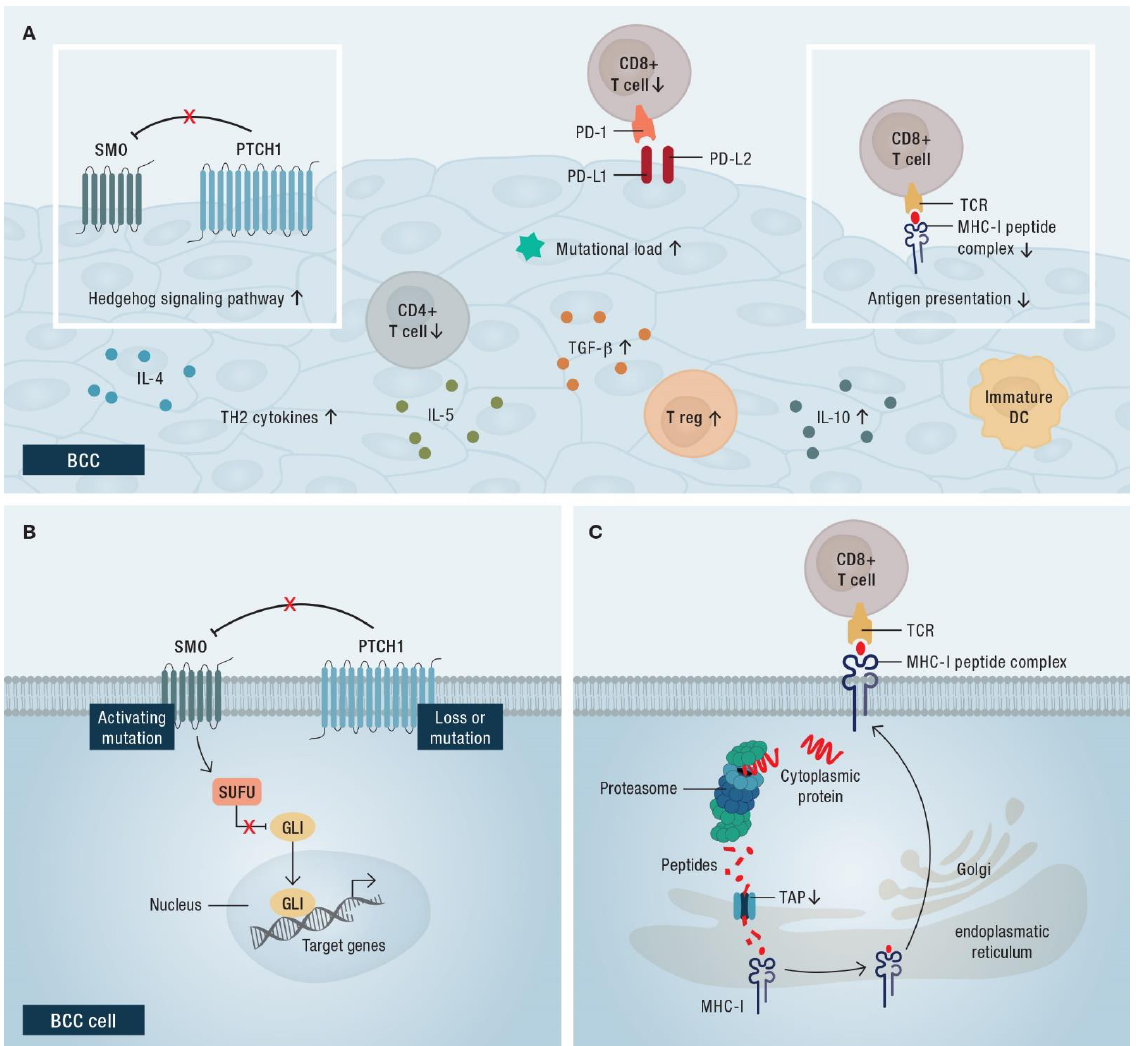
Figure 3. Schematic representation of the immunological aspects of the basal cell carcinoma (BCC). ( A ) The tumor microenvironment is characterized by decreased infiltration of CD4+ and CD8+ T cells and increased presence of regulatory T cells (T reg). Dendritic cells (DC) of an immature phe- notype are present in in the tumor microenvironment of laBCC. Increased expression of TH2 cyto- kines (interleukin [IL]-4, IL-5) and transforming growth factor (TGF)- β , as well as IL-10, supports an immunosuppressive environment surrounding the tumor. In addition to a high mutational load, tumor cells are characterized by the expression of the inhibitory molecules programmed cell death 1 ligand 1 (PD-L1) and PD-L2, which can suppress T cell activity by binding to programmed cell death protein 1 (PD-1) on T cells; ( B ) loss-of-function mutations in PTCH1 or activating mutations in SMO activate the HH signaling pathway in laBCC cells; ( C ) decreased expression of the trans- porter associated with antigen processing-1 (TAP-1) and major histocompatibility complex (MHC)- I lead to decreased recognition of tumor cells by the immune system. As PD-L1 expression levels are associated with response to PD-1 inhibitors in other cancer types, the expression of PD-1 and PD-L1 on BCC tumor cells and intratumoral im- mune cells was measured in two different studies. One study reported expression of PD- L1 on 22% of the analyzed BCC specimens and on 82% of tumor-infiltrating lymphocytes